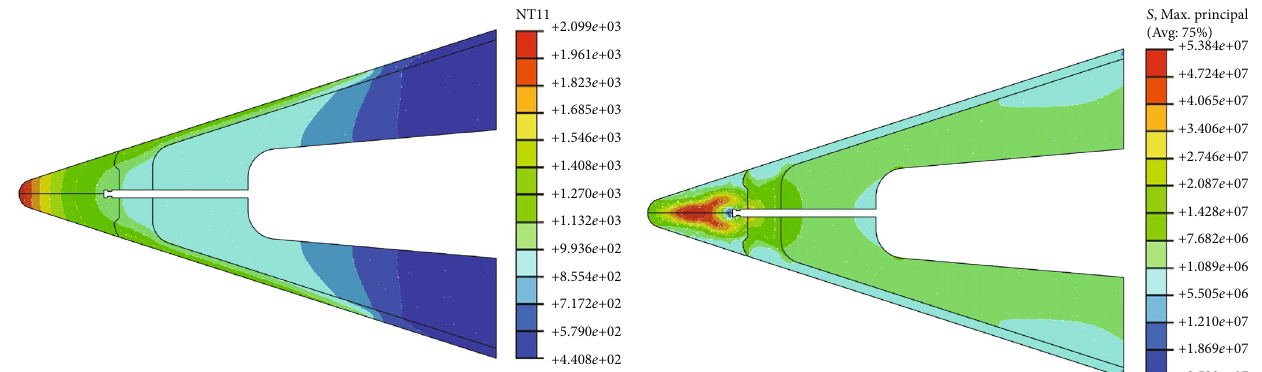
Figure 12: Nose cap features at 100 s.